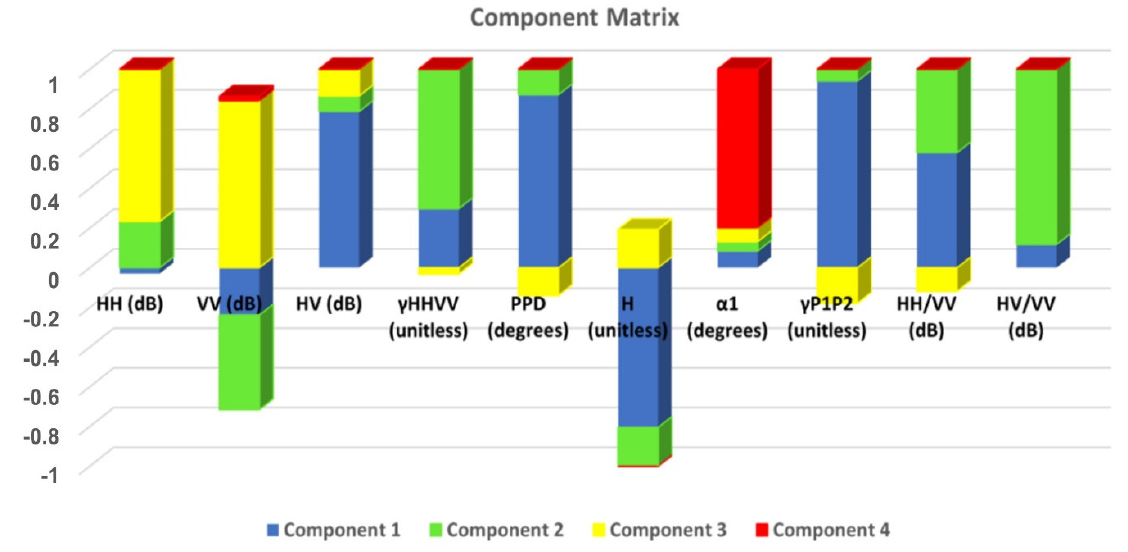
Figure 2. Factor parameters extracted from principal component analysis.